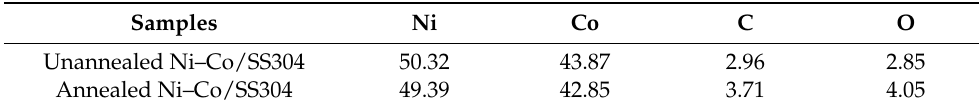
Table 1. Elements and contents (at.%) of Ni–Co/SS304 surface before and after annealing obtained by EDS.